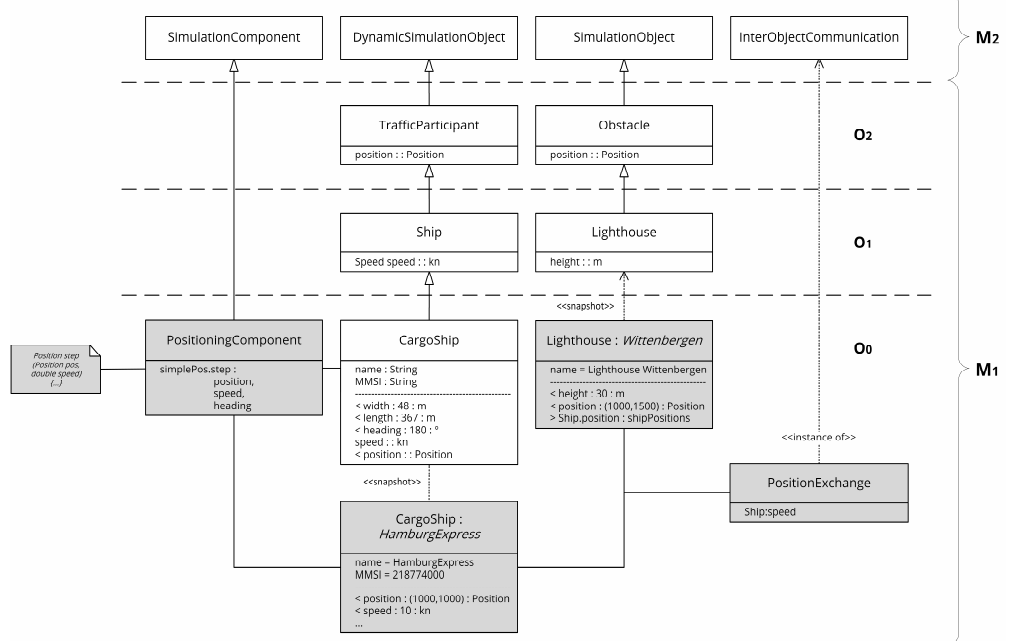
Figure 22. A simple minimal example of a maritime traffic scenario modeled using the metamodel TSSMeta (cf. Figure 16), which was previously created by the application of a heavyweight UML extension. The grey-colored boxes ultimately form the actual scenario model. The organization in packages in the sense of the adapted 6-layer model is not shown here in favor of a clearer